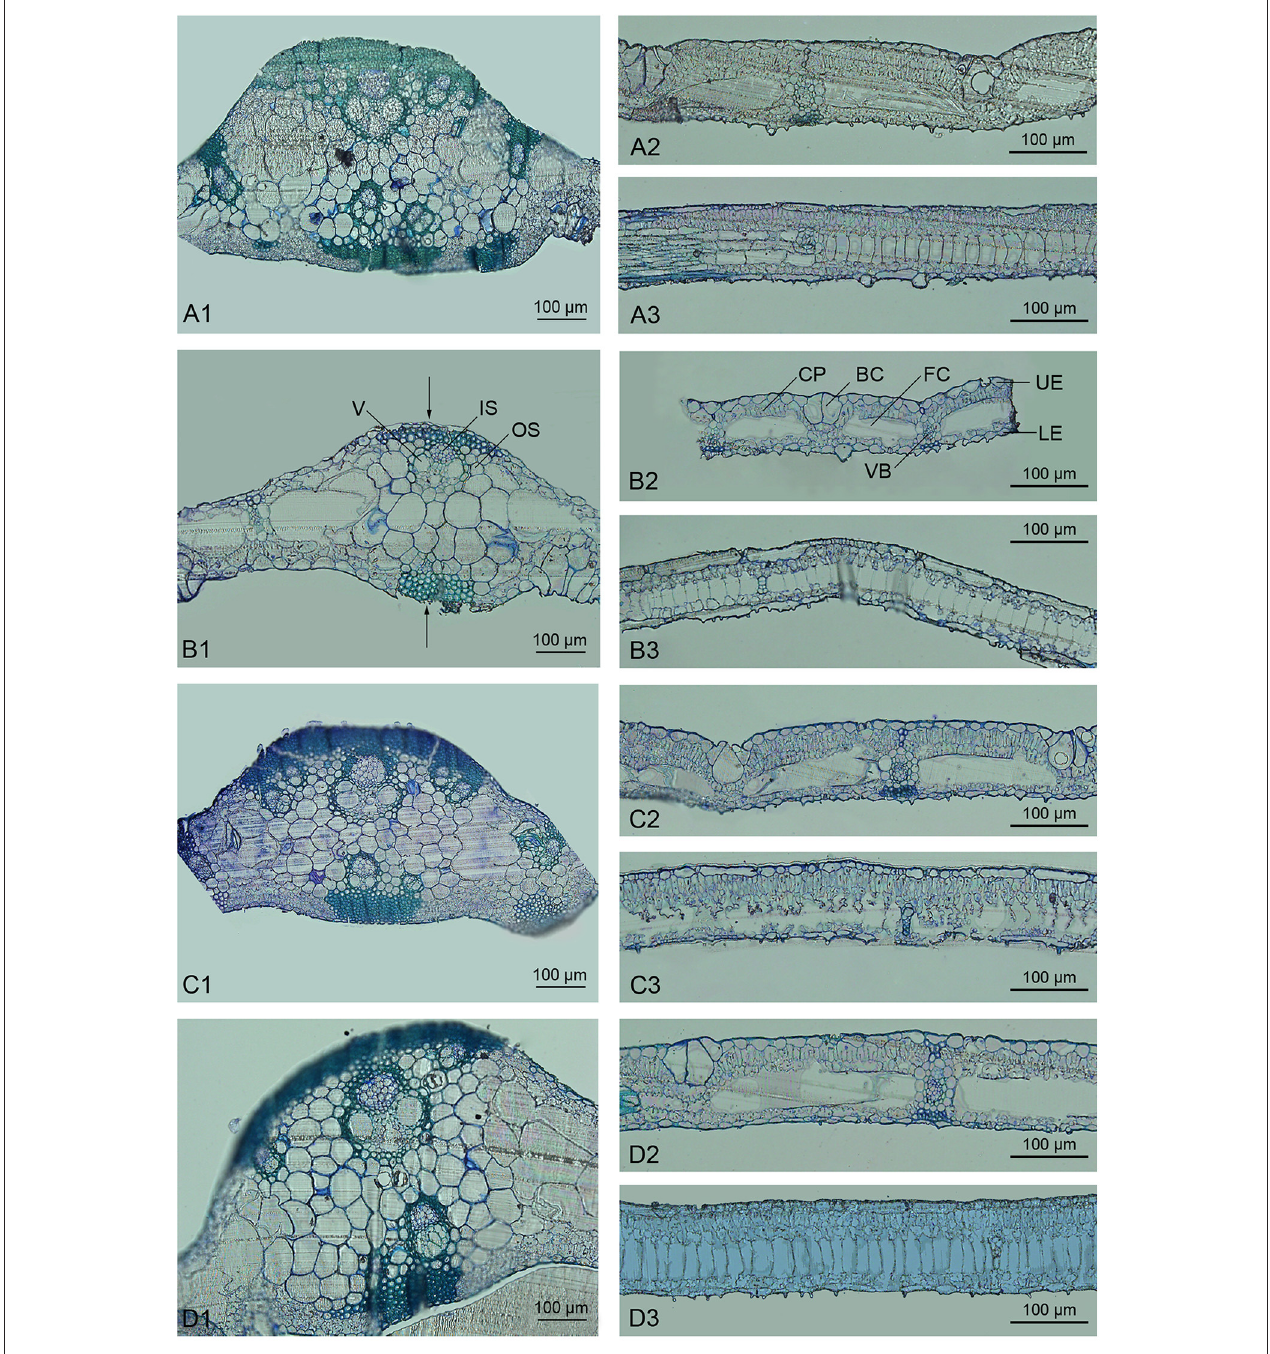
FIGURE 1 | Light micrographs of the leaves of Dendrocalamus latiflorus plants of different ploidy levels. V, Vessel; IS, Inner sheath; OS, Outer sheath; CP, Chlorophyllous parenchyma; BC, Bulliform cell; FC, Fusoid cell; UE, Upper epidermis; LE, Lower epidermis; VB, Vascular bundle. (A1–A3) , F1 seedlings 6X; (B1–B3) , triploid 3X; (C1–C3) , hexaploid 6X; (D1–D3) , dodecaploid 12X; (A1,B1,C1,D1) , transverse sections of midrib; (A2,B2,C2,D2) , intercostal regions; (A3,B3,C3,D3) , longitudinal section of intercostal regions, arrow indicates the sheath extension.